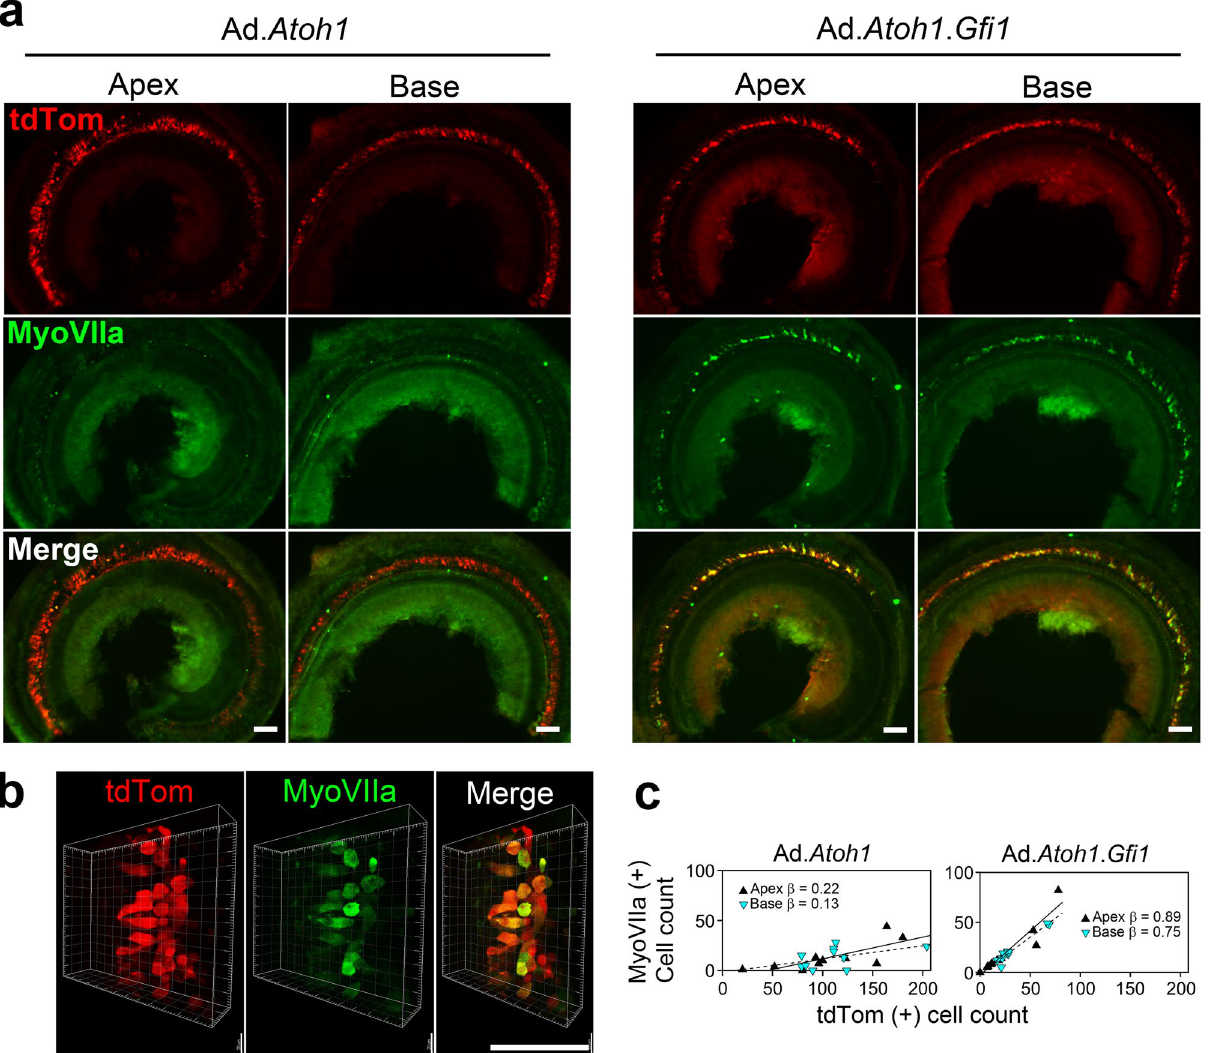
Figure 3. Gfi1 enhances Atoh1 -induced hair cell regeneration in the adult cochlea. Images show cochleae of adult mice 4 weeks after DT-induced HC (HC) ablation and adenovirus injection into scala media. The tdTomato (tdTom) reporter is robustly expressed in OC epithelial cells in both cochlear turns ( a ). Mice that received Ad. Atoh1 had fewer Myosin VIIa positive cells in both apical and basal turn than mice that received Ad. Gfi1.Atoh1 . Higher magnification images ( b ) show that Myosin VIIa-positive cells are large, variable in shape but usually round, and all co-express tdTom. Linear regression analysis ( c ) shows that the proportion of tdTom- positive cells that were also Myosin VIIa-positive were similar in the apex and base for both treatments and differed between treatments (see text for details). Scale bar = 100